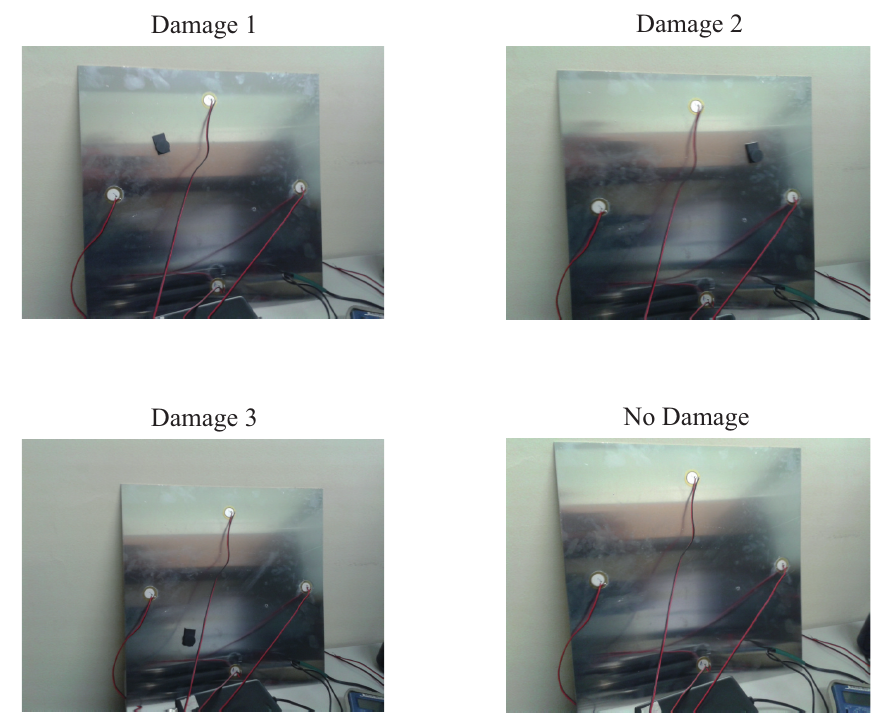
Figure 24. Experimental setup for the aluminum plate instrumented with four piezoelectric sensors and with different kind of